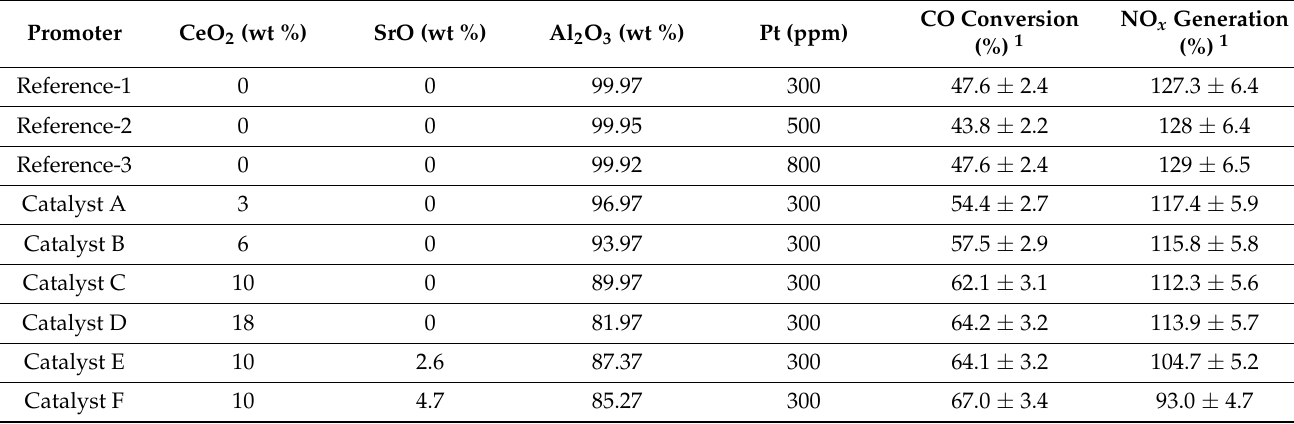
Table 1. The sample composition as well as measured CO conversion and NO x generation values for the catalysts discussed in this contribution are